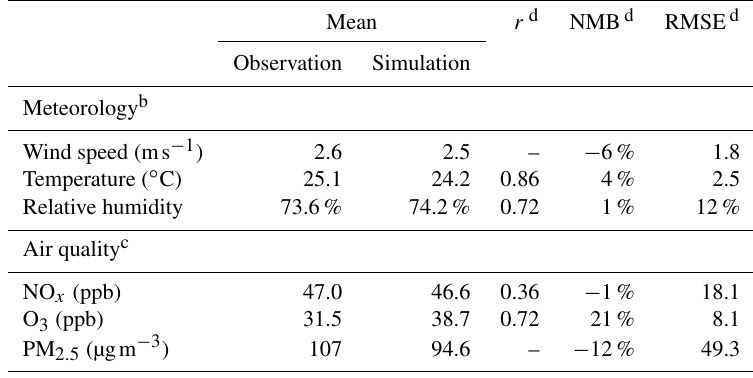
a Averaged for the period from 15 to 30 August 2011, excluding the rainy days. b Meteorological data were obtained from the hourly surface measurements at Jinghe station (34.26 ◦ N, 108.58 ◦ E). c Air quality data were measured at the roof (107 m above ground) of the main building (34.25 ◦ N, 108.98 ◦ E) on the campus of Xi’an Jiaotong University. d r : correlation coefficient; NMB: normalized mean bias; RMSE: root